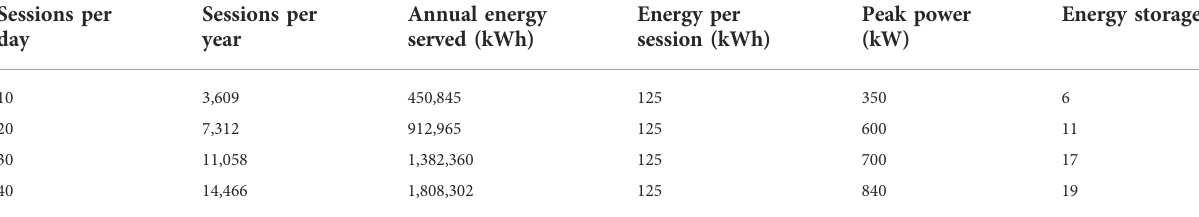
TABLE 1 Electric vehicle charging session summary. Sessions per